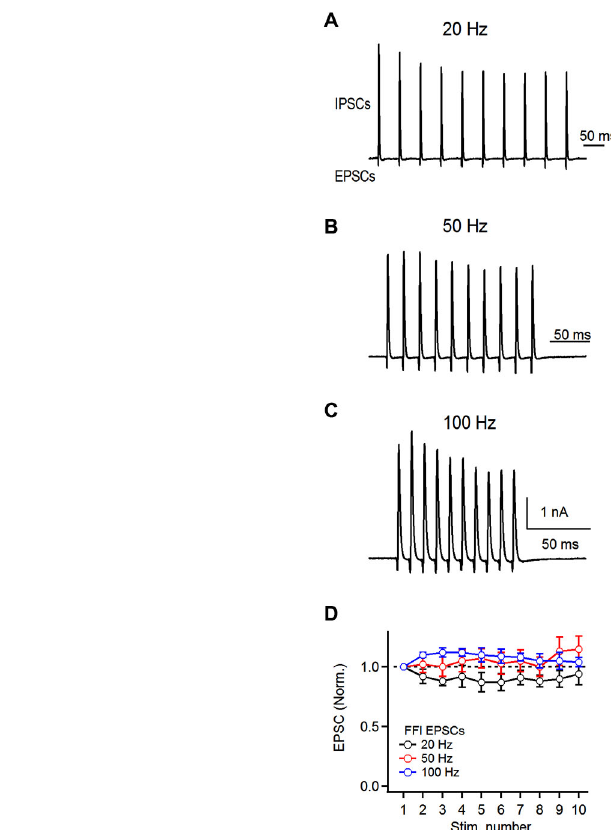
FIGURE 4 | Dynamics of feed-forward inhibitory circuit during repetitive auditory nerve activity. (A) Representative recordings of feed-forward inhibition. 10 stimuli were delivered to the auditory nerve at 20 Hz and short-term plasticity of both the excitatory and the inhibitory components was analyzed. Stimulation artifacts were removed for clarity from all traces shown. Response to the first (Stim 1) and 10th (Stim 10) are superimposed on